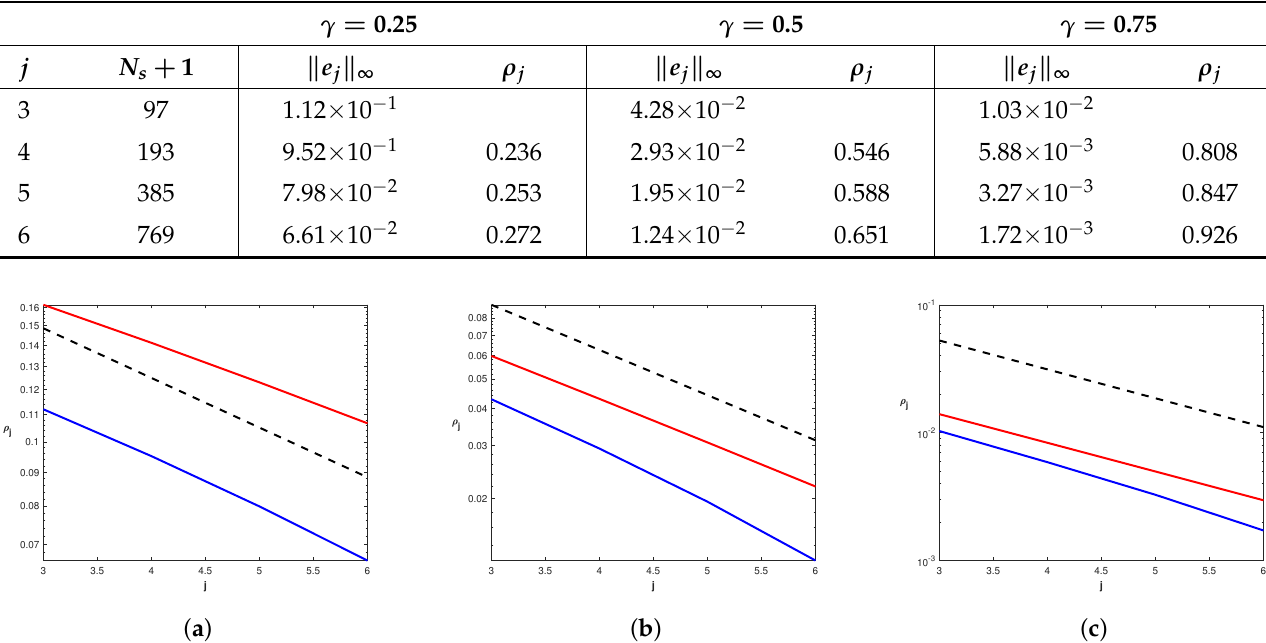
Figure 4. Example 2: The numerical convergence order ρ j for the quasi-interpolatory operator with r = 1 (red solid line) and r = 2 (blue solid line) for γ = 0.25 (Panel ( a )), γ = 0.5 (Panel ( b )), and γ = 0.75 (Panel ( c )) is displayed as a function of j . The black dashed line has the same slope as the theoretical convergence